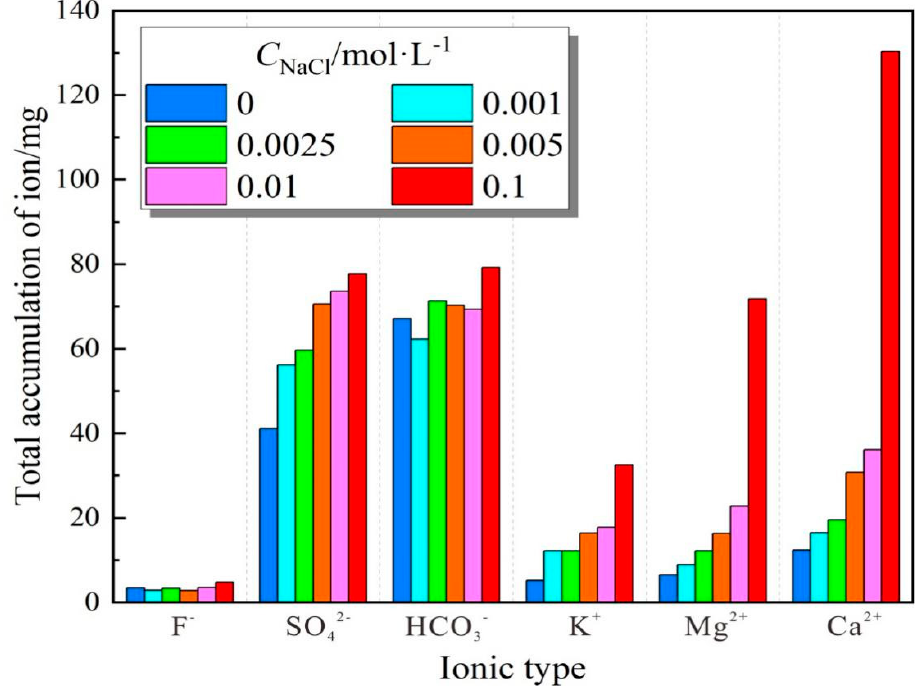
Figure 6. The influence of NaCl solution concentrations on the total cumulative mass of ions in the leachate.